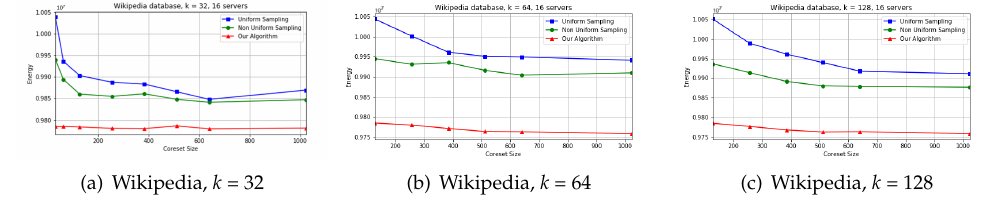
Figure 4. Comparison of uniform sampling, non uniform sampling and our algorithm based on Wikipedia in distributed setting with 16 servers.